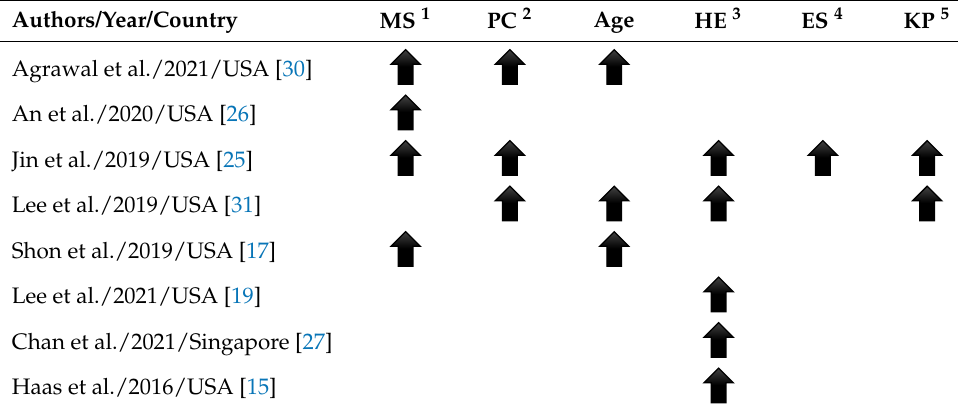
Table 3. Adherence to breast cancer–screening program according to family/personal history, marital status and educational level.